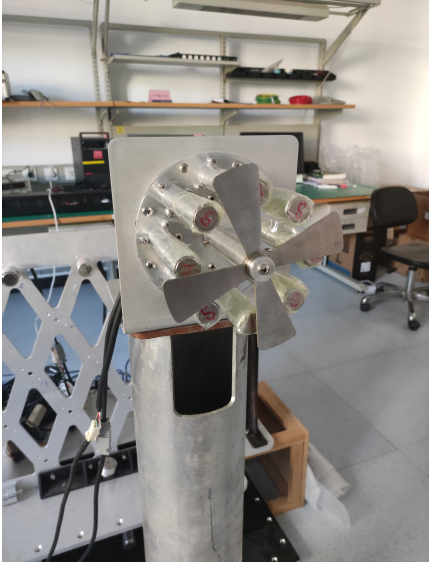
Figure 7. The rotating shutter antenna.